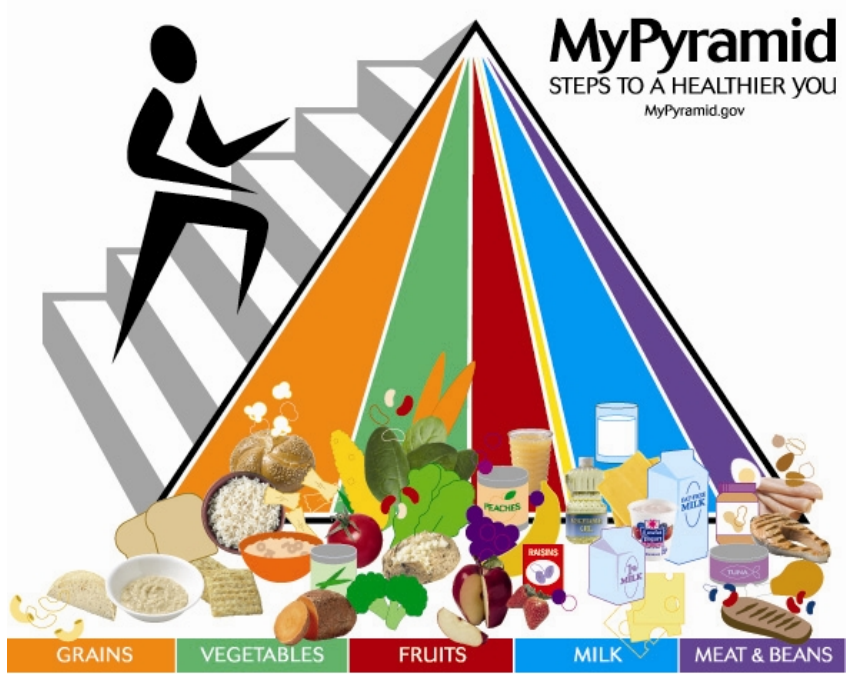
Figure 4. The USA MyPyramid food guide. USDA, Unites States Department of Agriculture.